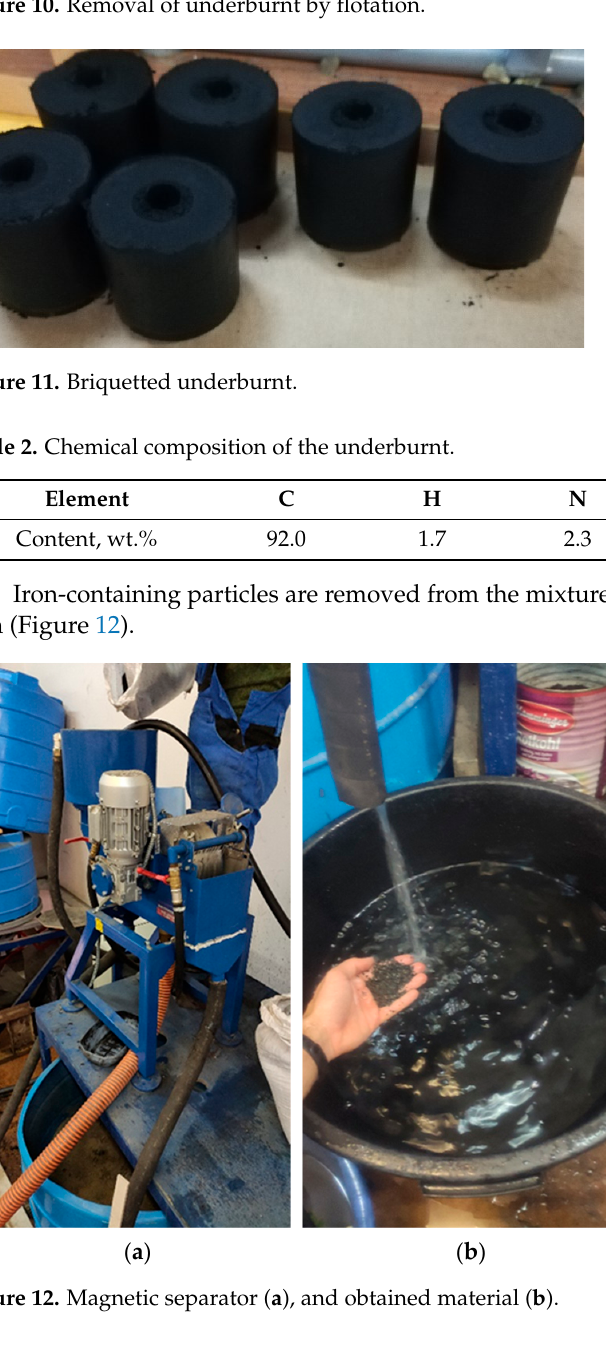
Table 2. Chemical composition of the underburnt.